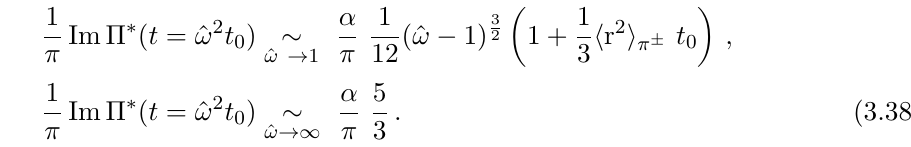
Im Π ∗ ( t ) in eq. (3.37) versus t π